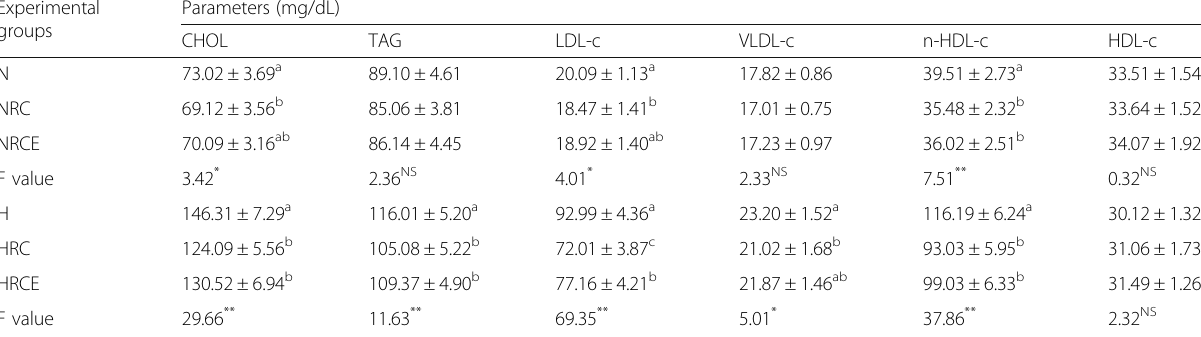
Table 2 Effect of diets on lipidemic profile of rabbits Experimental